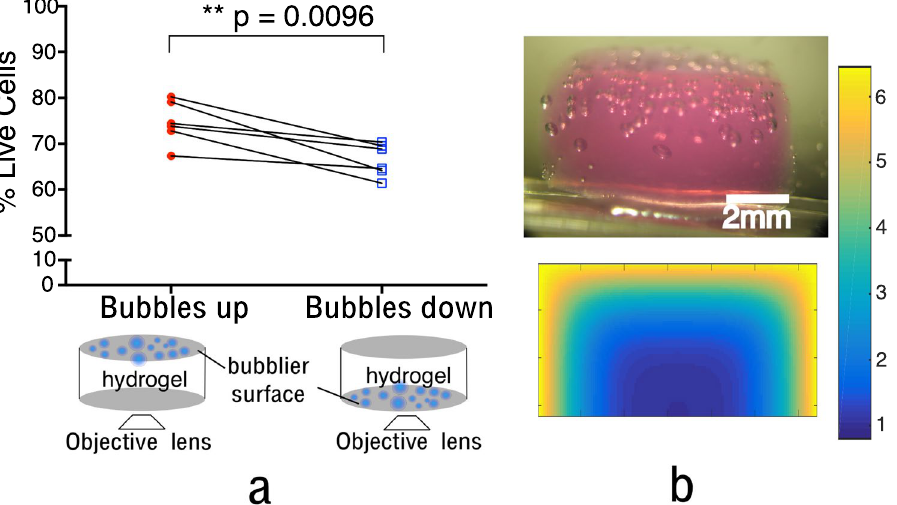
Figure 7. ( a ) The result of the post exposure live dead measurement spilt according to the orientation of the gel. Diagram of the orientation is shown below the plot. A statistical difference is found between the two orientations as assessed by a paired t-test (p = 0.0096 N = 6), ( b ) Upper image shows a cross-sectional view of a tissue phantom post dive, an inhomogeneous distribution of bubbles can be seen. Lower image shows a mid- point cross section of the simulated dissolved gas concentration within the phantom just prior to decompression i.e. (time 0 secs in Fig. 2b). The values have been non-dimensionalised to the atmospheric pressure. Simulation parameters are detailed in the